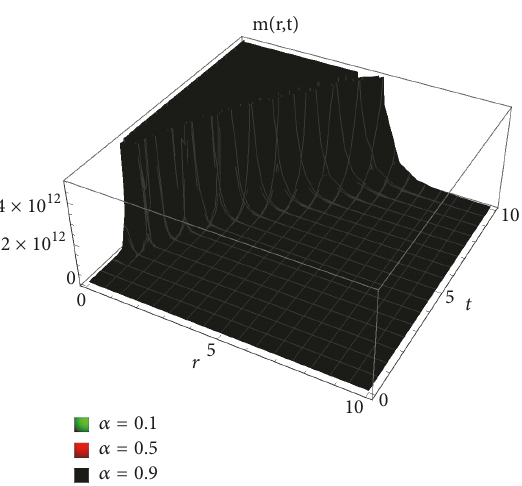
Figure 8: Radial pressure behavioralong 𝑟 and 𝑡 for 𝑟 0 = 0.5 and the different values of 𝛼 .